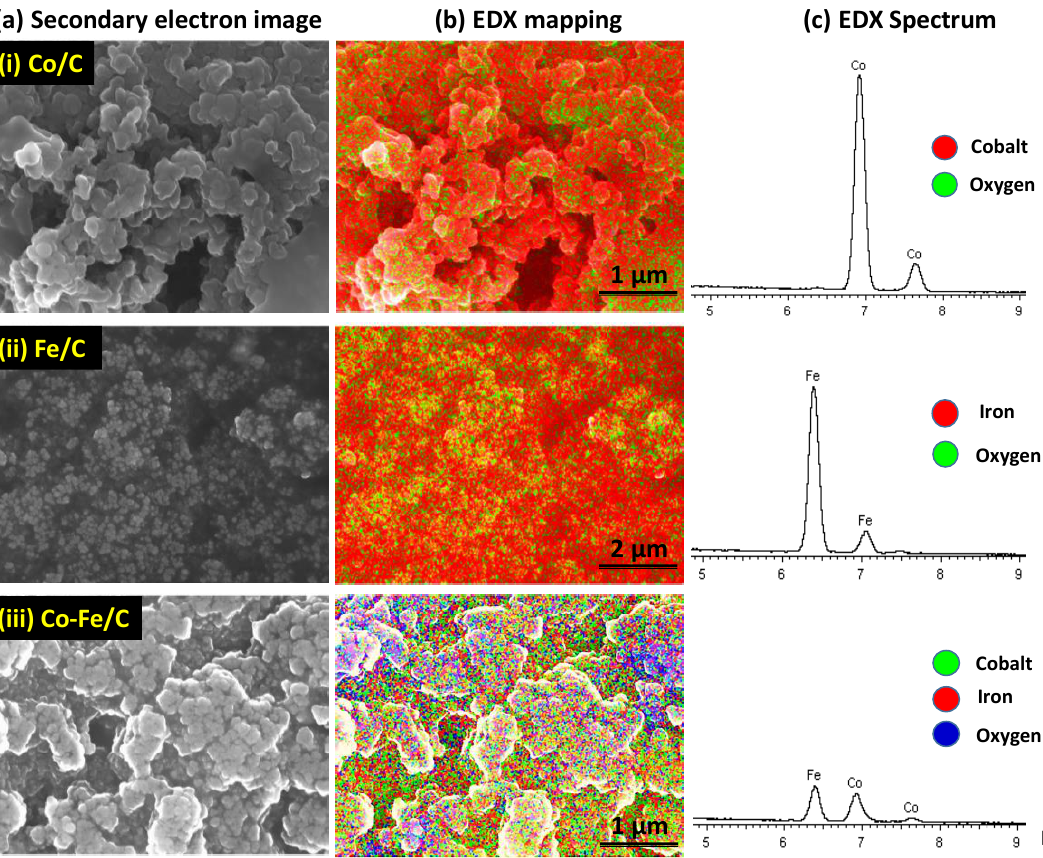
Figure 11. Sample SEM images of the used catalysts: ( i ) Co/C ( ii ) Fe/C and ( iii ) Co-Fe/C displaying ( a ) secondary electron images. ( b ) elemental EDX mapping, and ( c ) EDX spectra.